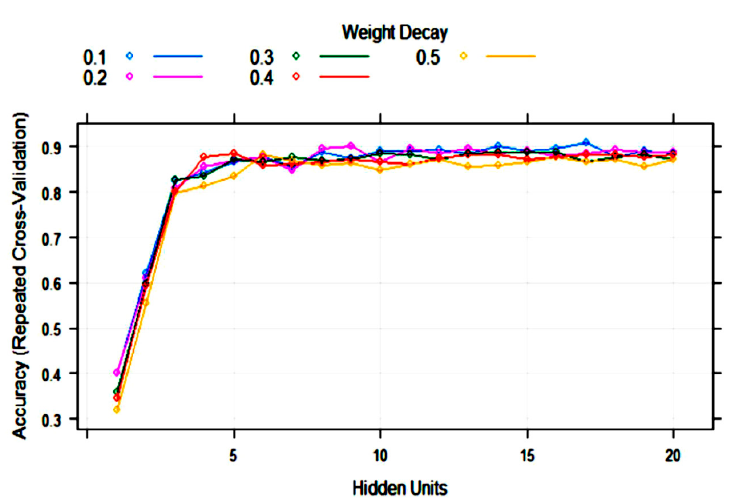
Figure 5. Change in the artificial neural network (ANN) accuracy during training with 10-fold cross-validation with the number of hidden units (nodes) and weight decay.